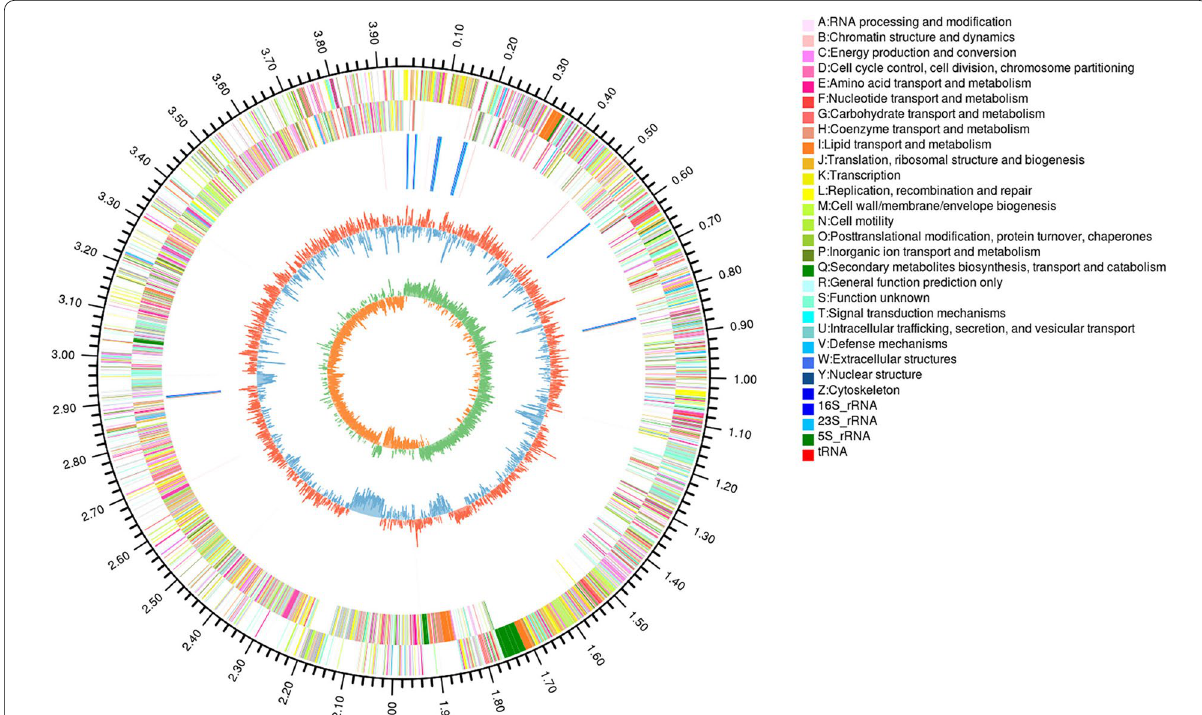
Fig. 1 Circular map of the genome of the B. amyloliquefaciens strain Bam1. The distribution of the circle from the outside to the inside indicates the genome size, forward CDS, reverse CDS, repeat sequences, tRNA (blue), rRNA (purple), GC ratio (reddish-orange and blue indicate regions, where the GC ratio is higher than average and lower than average, respectively), and GC skew (cyan and orange indicate regions, where the G content is greater than and less than the C content,